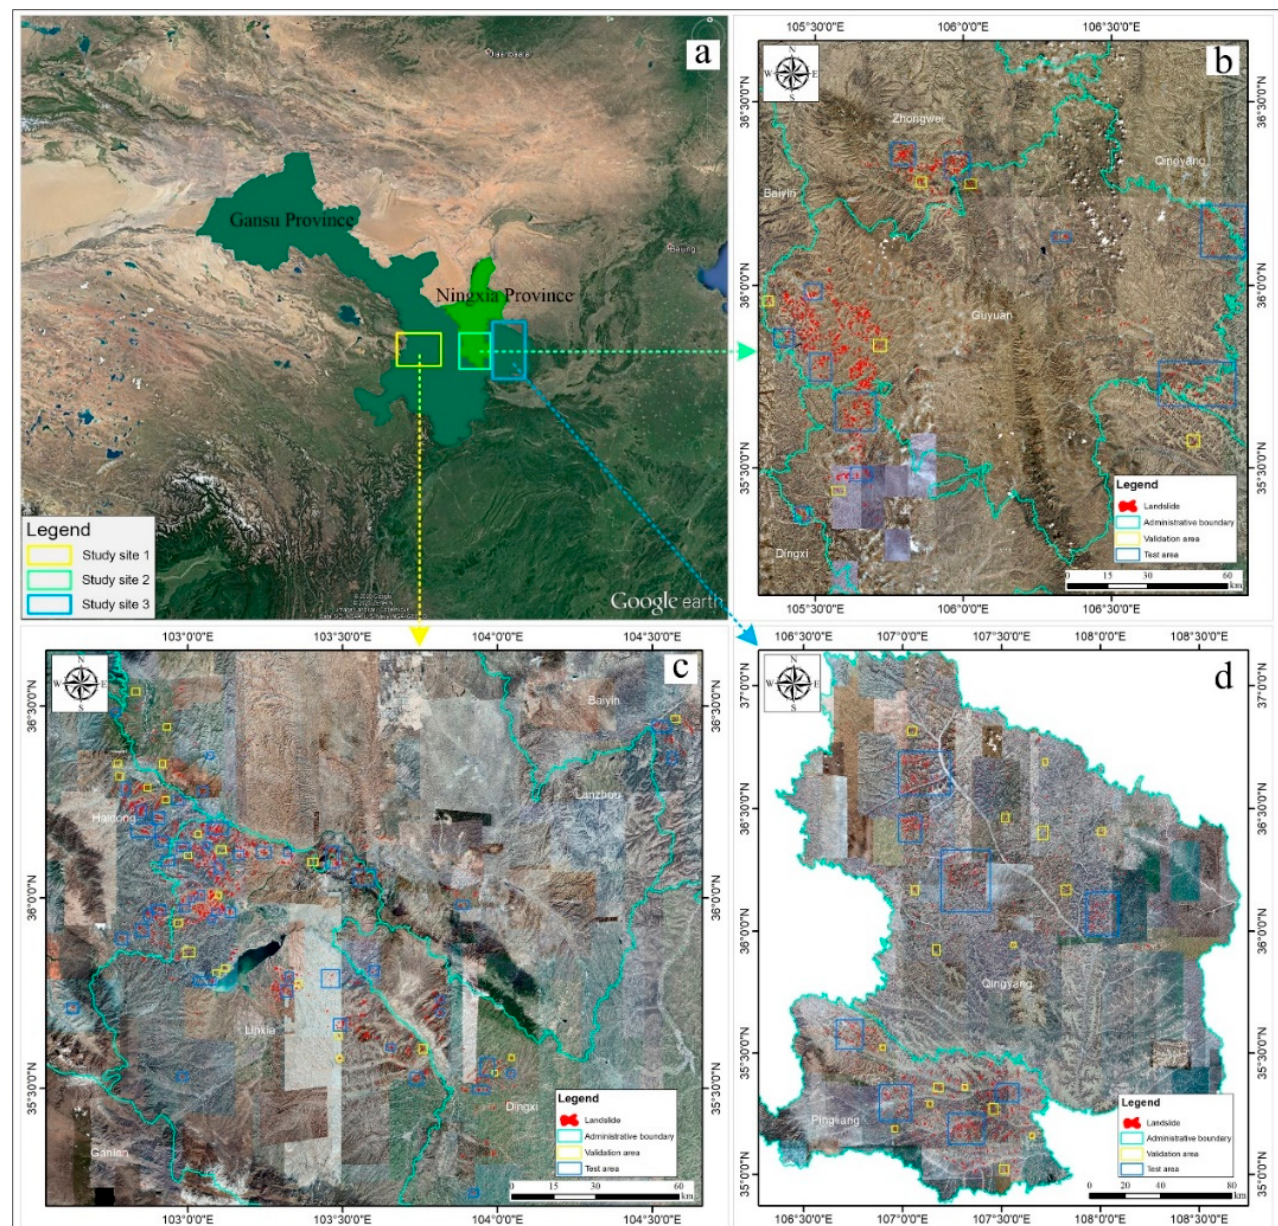
Figure 1. Location of study sites: ( a ) location of study site on Google Earth; ( b ) the distribution of landslides at study site 2; ( c ) the distribution of landslides at study site 1; ( d ) the distribution of landslides at study site 3.